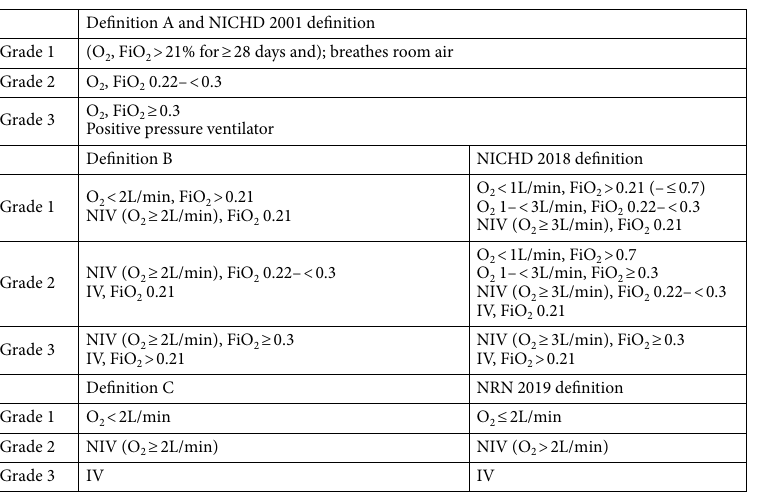
Table 6. Definitions of bronchopulmonary dysplasia. NICHD National Institute of Child Health and Human Development; NIV non-invasive ventilator; IV invasive ventilator; NRN Neonatal Research